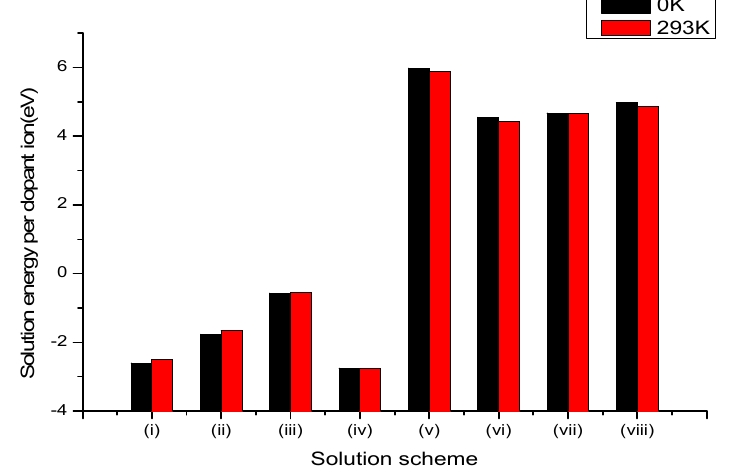
Figure 1. Bar chart of solution energies vs. solution schemes for divalent dopant (V 2 + ) at the Li and Nb sites, considering the first neighbours in relation to the c axis.